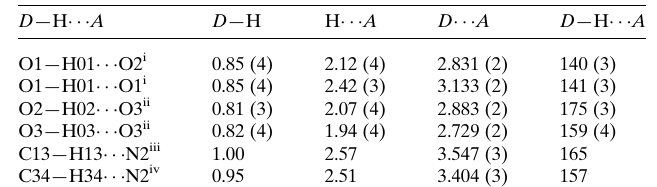
Table 1 Hydrogen-bond geometry (A˚ , (cid:2) ).